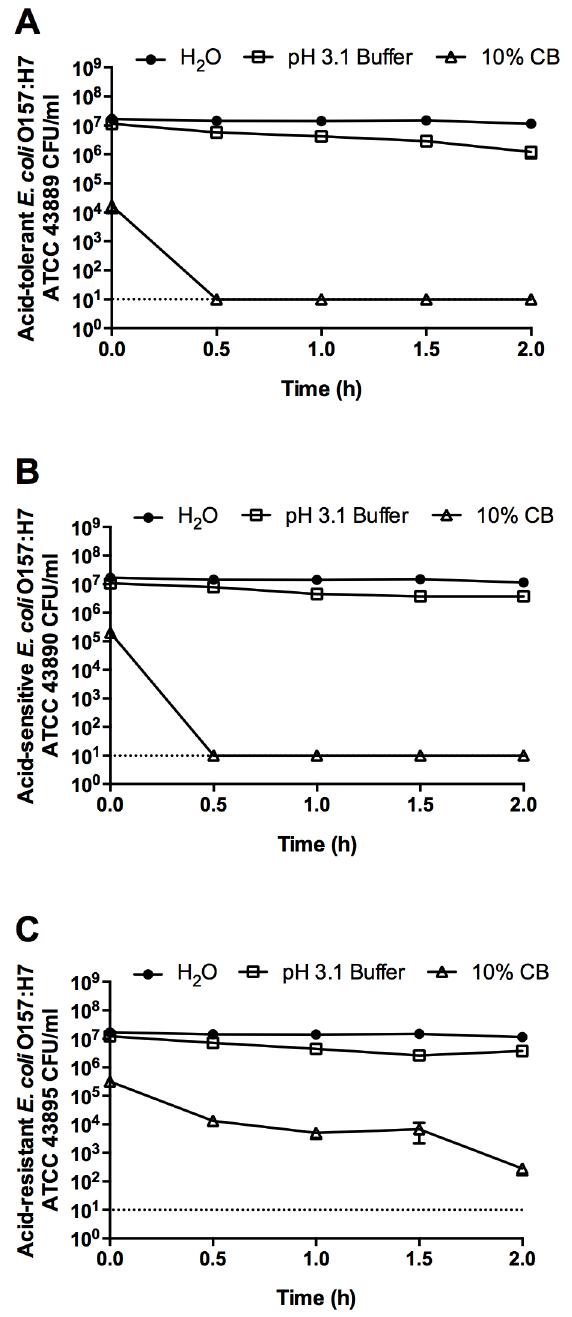
Fig. 1. Stationary-phase, acid-tolerant (A), acid-sensitive (B), and acid-resistant (C) E. coli O157:H7 in 10% CB suspension (pH 3.1) and low-pH buffer (pH 3.1). Stationary-phase cells were grown overnight in LB media. Data are presented as the mean ¡ standard deviation (SD) for three independent experiments. The dotted line represents the limit of